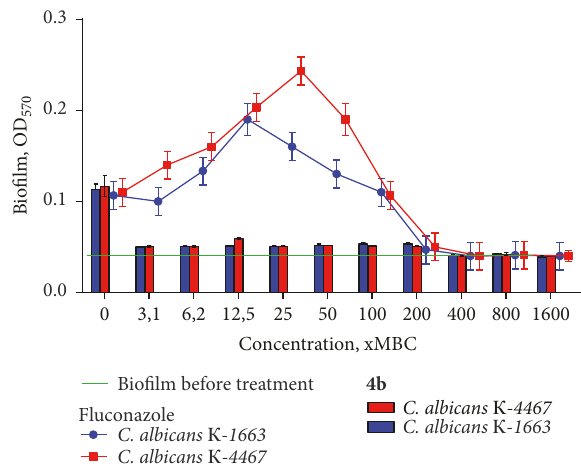
Figure 1: The effect of fluconazole and 4b on C. albicans biofilm formation. The 24-h biofilms (green line) were treated with 3.1–1600 𝜇 g/mL of fluconazole (lines) or 4b (bars) for 48h and quantifiedwithcrystalvioletassay.Dataarepresentasaveragesfrom five independent experiments with standard deviations. C. albicans P -1663 isolated from pharynx mucosa (blue) and C. albicans P -4467 isolated from skin (red) were